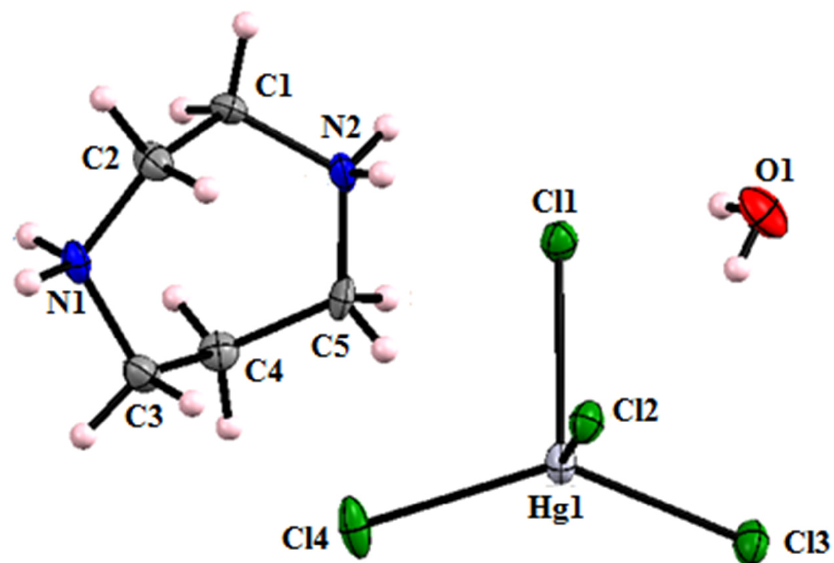
Figure 2. The asymmetric unit of (C 5 H 14 N 2 )[HgCl 4 ] · H 2 O.